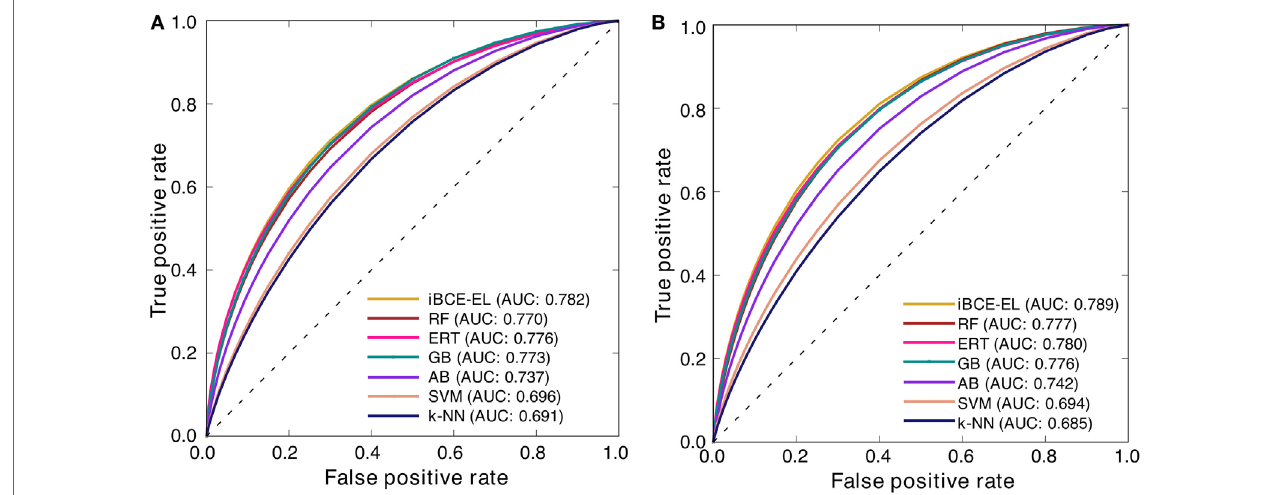
FIGURe 5 | Receiver operating characteristic curves of the various prediction models. Results of 5-fold cross-validation on (A) a benchmarking data set and (B) independent data